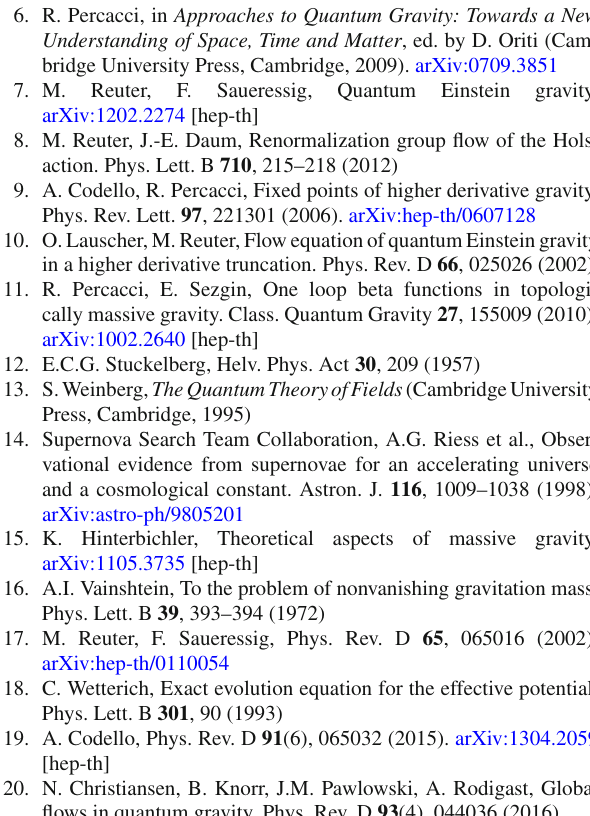
= 0 , 0 . 1 and 0 . 5. Here λ k ( g k ) is in the x (y) axis k